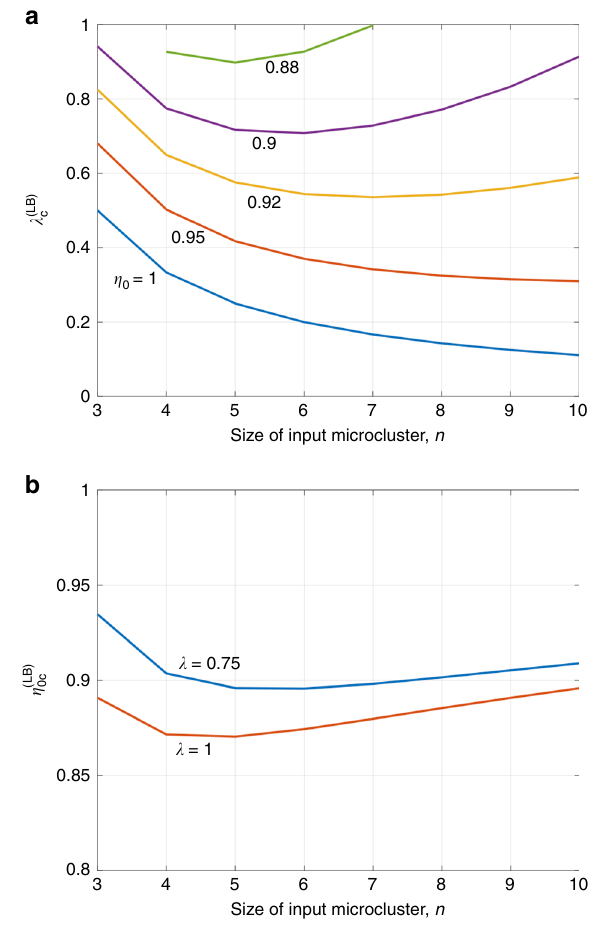
Fig. 9 Effect of photon loss on thresholds. a A loss-dependent lower bound λ ð LB Þ on the critical fusion probability λ c as a function of the input c microcluster size n for different values of η 0 ; ( b ) a loss-dependent lower bound η ð LB Þ on the critical loss parameter η 0 as a function of n for different 0 c values of fusion success probability